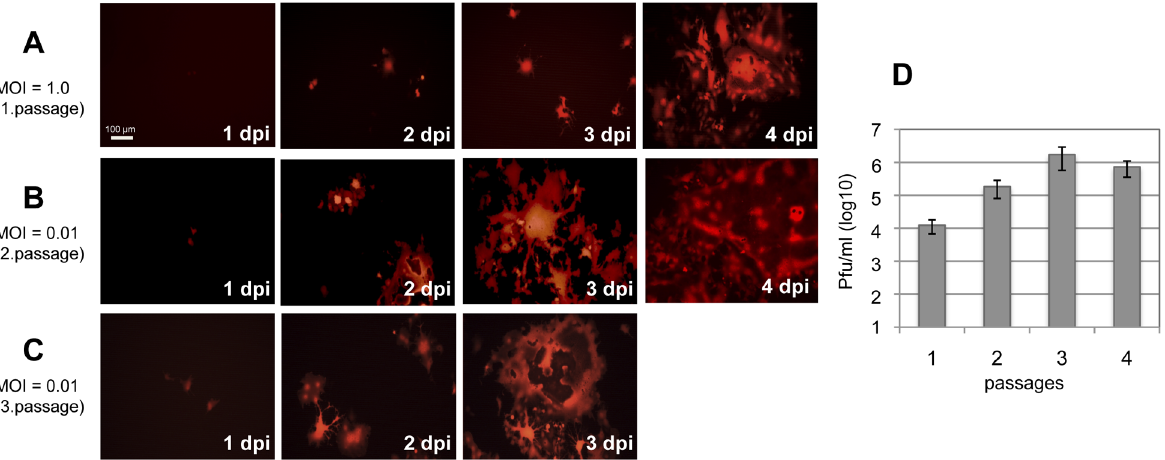
Figure 2. Infection of Vero-hSLAM cells with CDV-A75/17 red . Human CD150-expressing Vero cells (Vero-hSLAM) were infected with recombinant wild-type CDV-A75/17 red at a MOI of 1.0 ( A ), incubated for the indicated times and pictures of the red autofluorescence taken under UV light. At 4 days post-infection (dpi) virus was prepared and titrated, and Vero-hSLAM cells infected at a MOI of 0.01 ( B ). After 4 dpi virus was again prepared and titrated, and Vero-hSLAM cells were infected with this virus at a MOI of 0.01 for indicated times ( C ). Titres of the virus preparations were determined using Vero-cSLAM cells and are given in ( D ). Photomicrographs of the autofluorescent virus-encoded tD tomato red were taken under UV light (bar=100 m